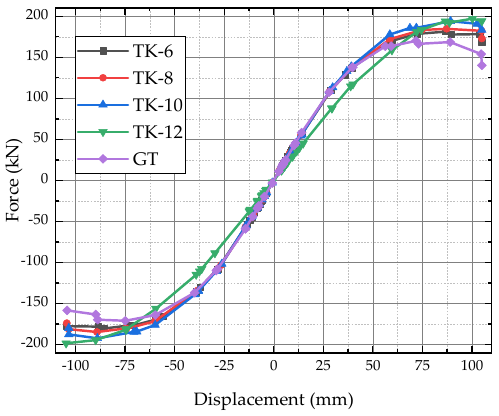
Figure 26. Skeleton curve of TK-6, TK-8, TK-10, TK-12, and GT.